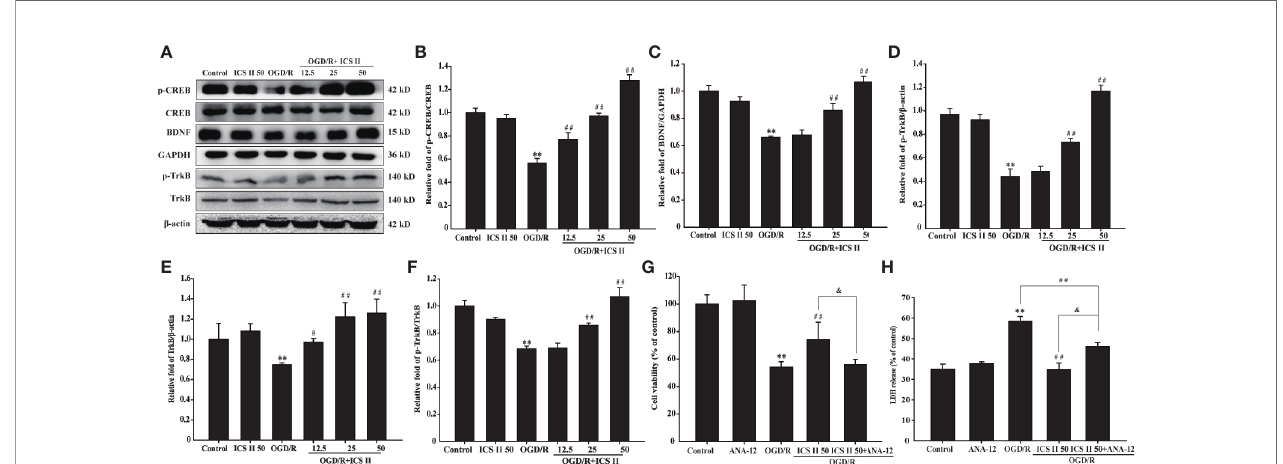
FIGURE 3 | ICS II up-regulated the expressions of BDNF, p-TrkB, TrkB, and p-CREB after OGD/R insult. (A) Representative Western blot images of BDNF, p-TrkB, and TrkB. (B) Quantitation of BDNF. (C) Quantitation of p-TrkB. (D) Quantitation of TrkB. (E) Representative Western blot images of p-CREB and CREB. (F) Quantitation of p-CREB/CREB. TrkB-speci fi c inhibitor ANA-12 abolished the bene fi cial effects of ICS II. (G) Cell viability tested by MTT assay. (H) LDH release was detected using an LDH release assay kit. Data are presented as means ± SD (n = 3). ** P < 0.01 versus control group; # P < 0.05, ## P < 0.01 versus OGD/R group, & P < 0.01 versus OGD/R+ ICS II 50 group.